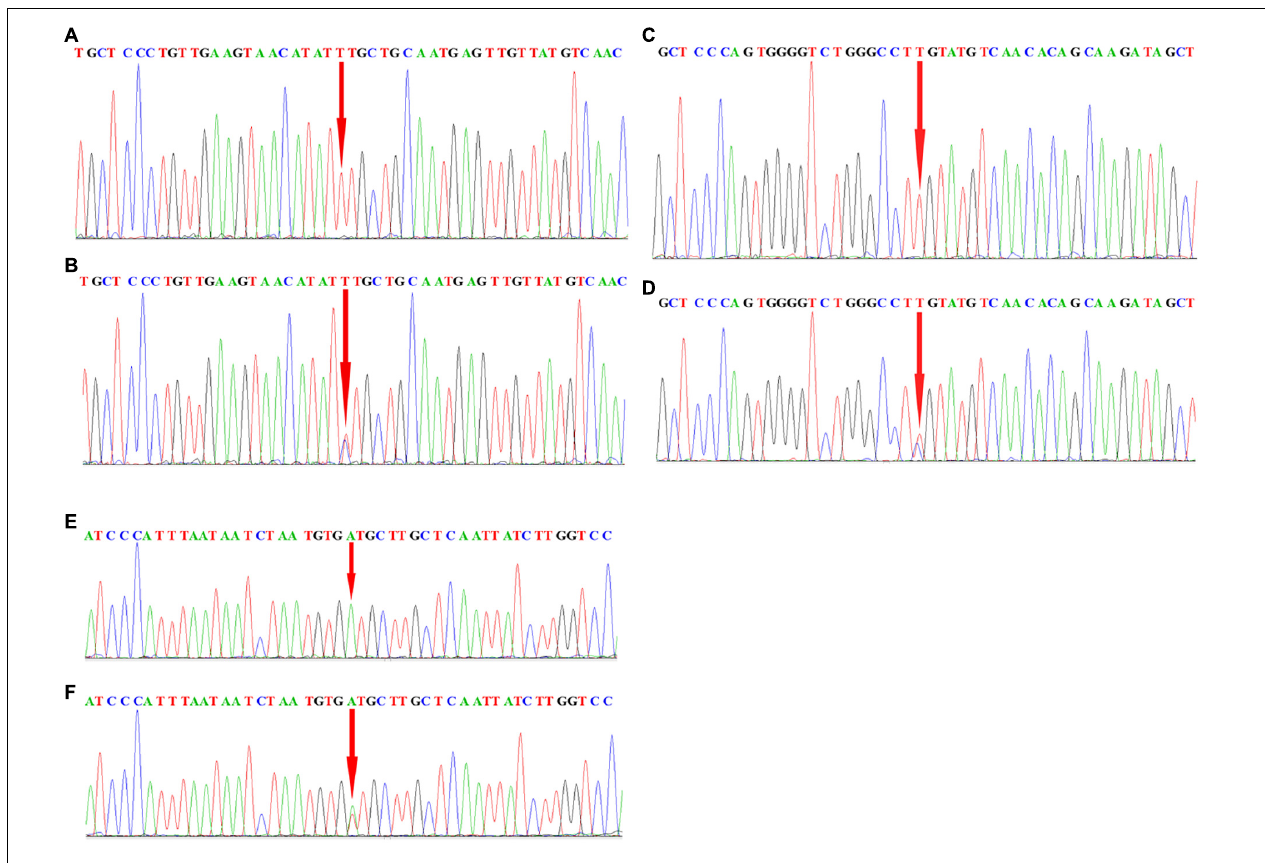
FIGURE 2 | Sequencing data showing rs2619566 in CNTN4 , rs10260404 in DPP6 , and rs79609816 in INPP5B . (A,B) Peak graph showing the rs2619566 T > C variation in the CNTN4 gene. (C,D) Peak graph showing the rs10260404 T > C variation in the DPP6 gene. (E,F) Peak graph showing the rs79609816 A > T variation in the INPP5B gene. The variant loci are indicated by using a red